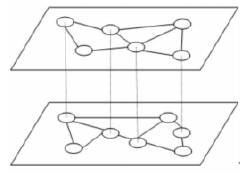
(Figure 3) for the multi-level knowledge graph structure diagram.